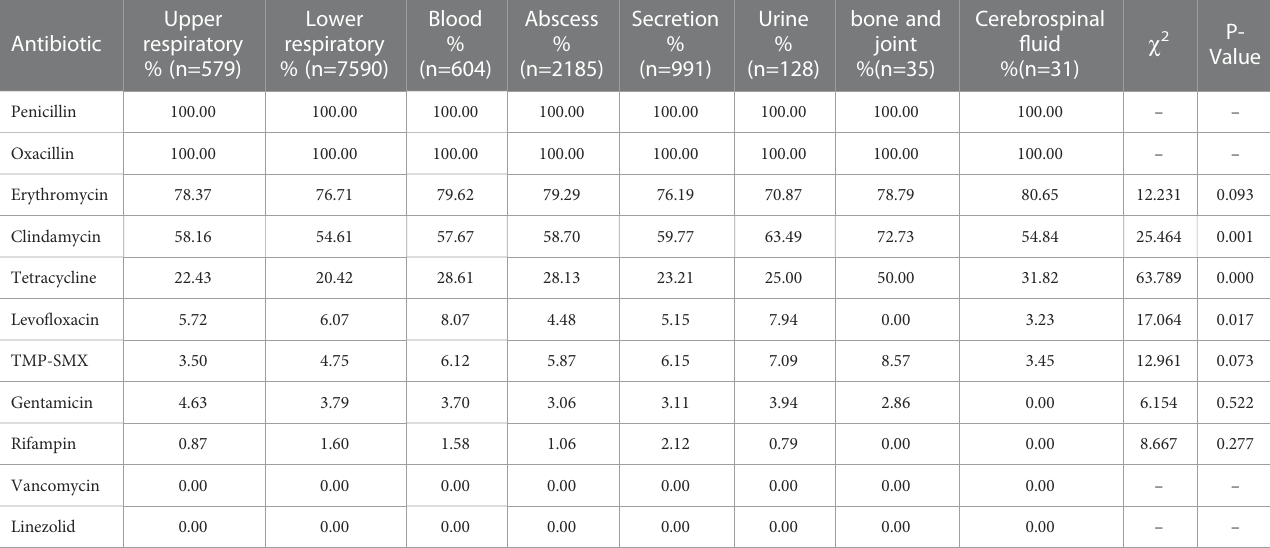
TABLE 4 Antibiotic resistance rates of MRSA from different site of infection. Upper Antibiotic respiratory